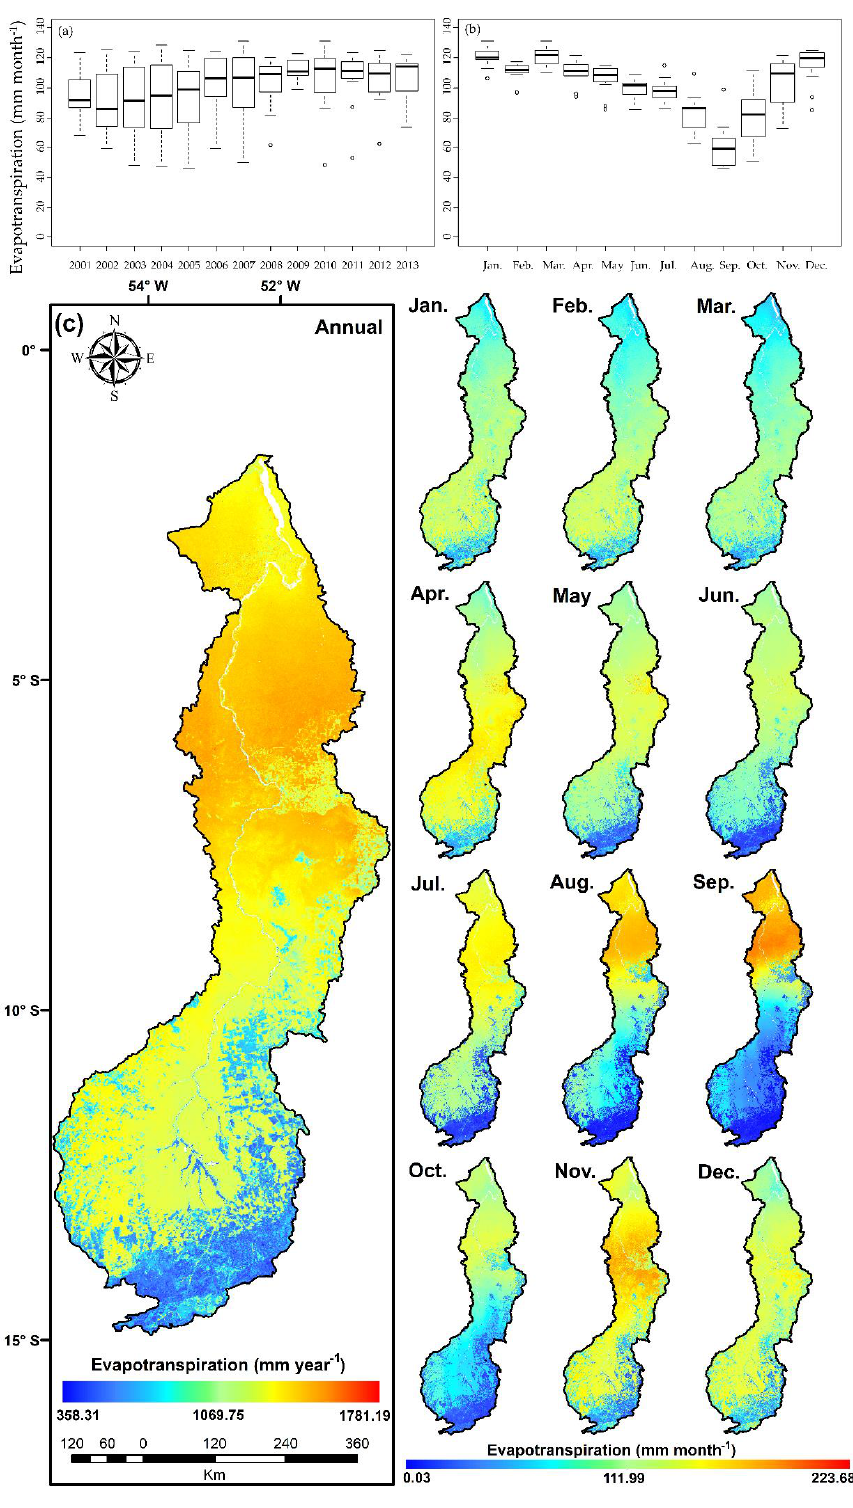
Figure 5. ( a ) Intra-annual boxplot for the monthly average evapotranspiration (ET), ( b ) interannual boxplot for the monthly average ET in the Xingu River Basin for the 2001–2013 period, and ( c ) spatial distribution of annual average PPT and monthly average ET in the Xingu River Basin for the 2001–2013